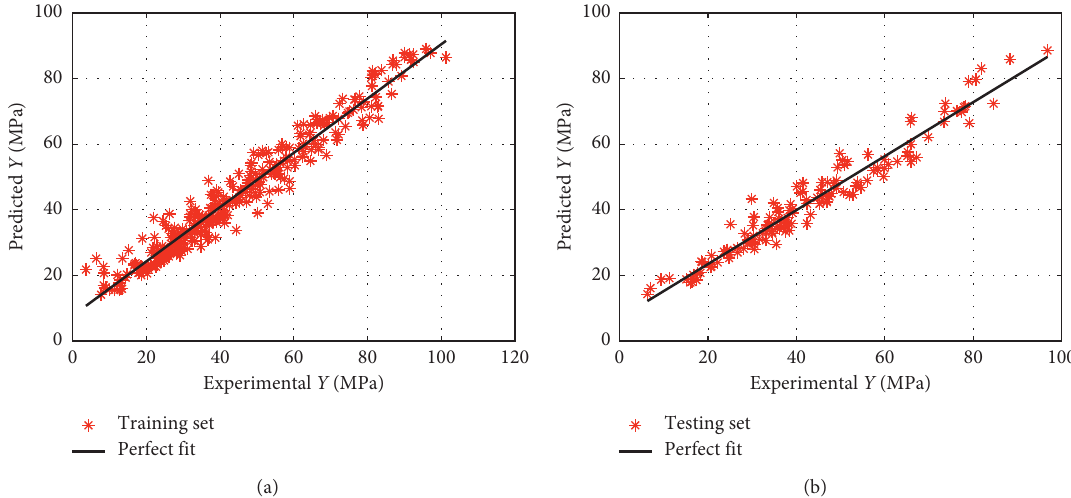
Figure 7: Regression graphs of the best predictor RF between experimental and predicted compressive strength: (a) training dataset and (b) testing dataset.